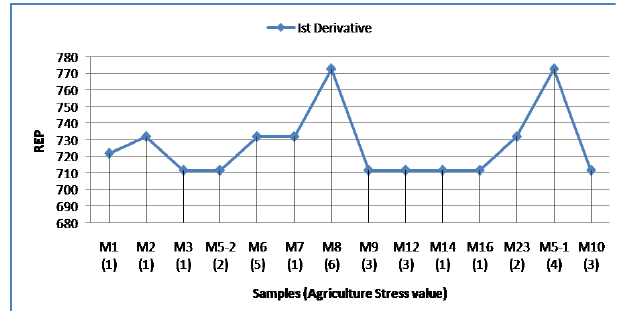
Figure 7: REP for mulberry plants using ENVI tool Figure 6 shows REP for mulberry plants using